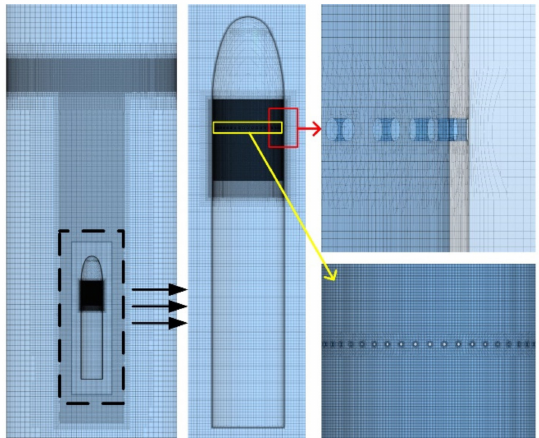
Figure 9. Schematic of numerical